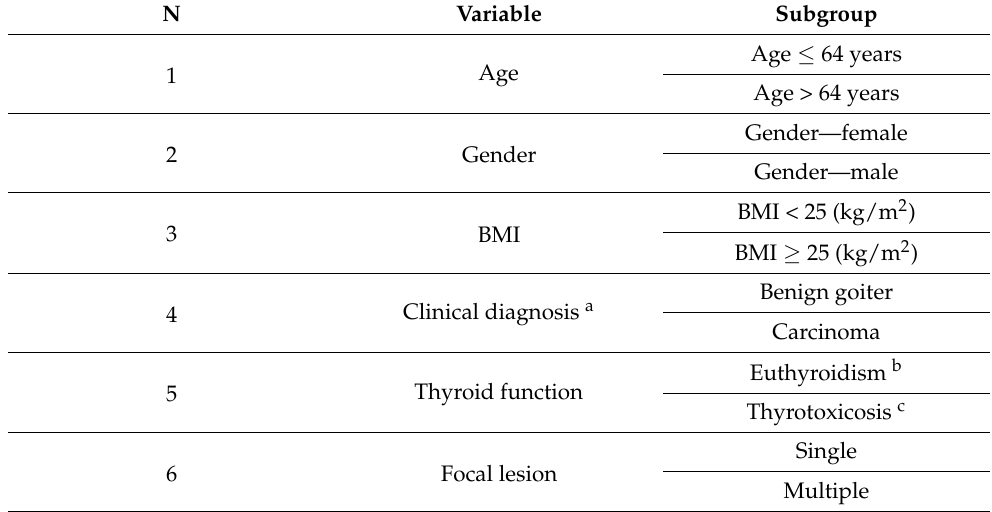
Table 2. Risk factors for complications of vocal cord paralysis: dichotomous variables of meta- analyses. a Benign goiter (nodular goiter, toxic nodular goiter and Graves’ disease); b euthyroidism; c thyrotoxicosis; d thyroid volume (volume of one lobe = length × depth × width × π /6; e, f based on X-rays of the neck and chest; g low-risk operation (nodular goiter and toxic nodular goiter); h high-risk operation (Graves’ disease and